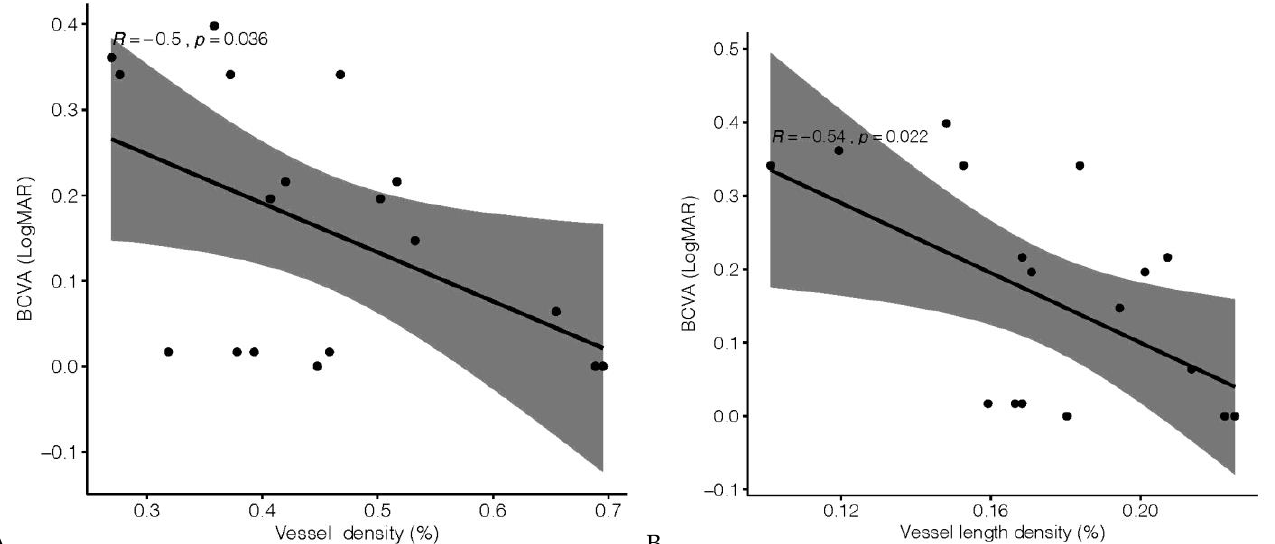
Figure 2. Linear correlation between best-corrected visual acuity (BCVA) and optical coherence tomography (OCTA) parameters at the inclusion date. ( A ) Linear correlation between BCVA and vessel density (VD). ( B ) Correlation between BCVA and vessel length density (VLD). See Methods (Section 2) for more details on these